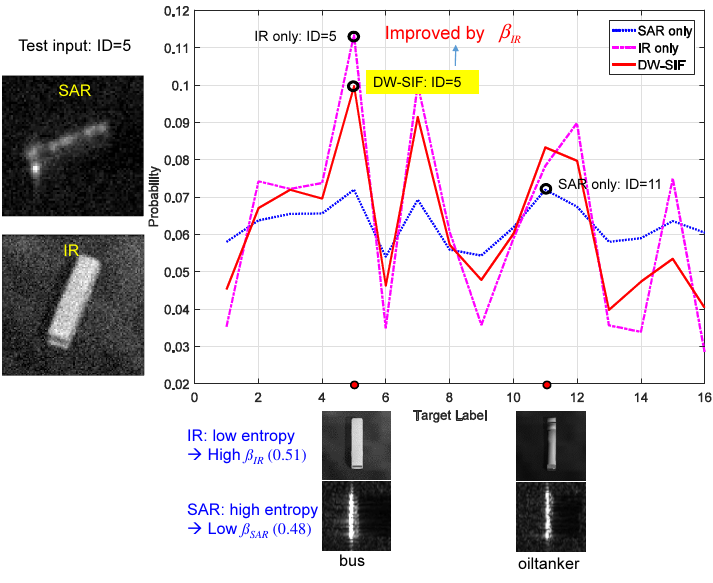
Figure 10. Effect of the online weights ( β SAR , β IR ) in SAR-IR sensor fusion (linear fusion